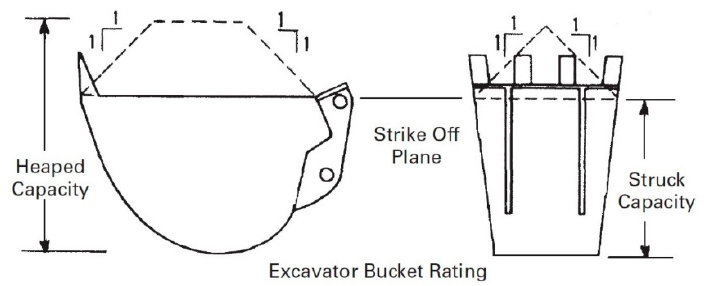
Figure 4. SAE and ISO excavator bucket rating [32].